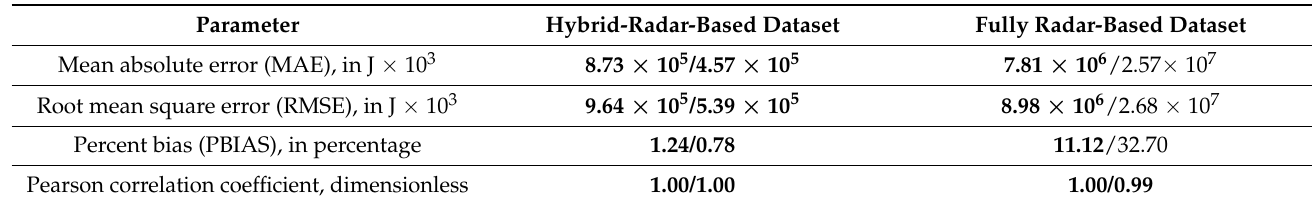
Table 6. Goodness-of-fit statistics associated with radar-based and USGS-streamgage-based Ω estimates in the following format: τ ∗ derived/ τ ∗ derived. Values in bold indicate they c , Mueller c , Lamb meet this study’s criteria for satisfactory performance defined in Section